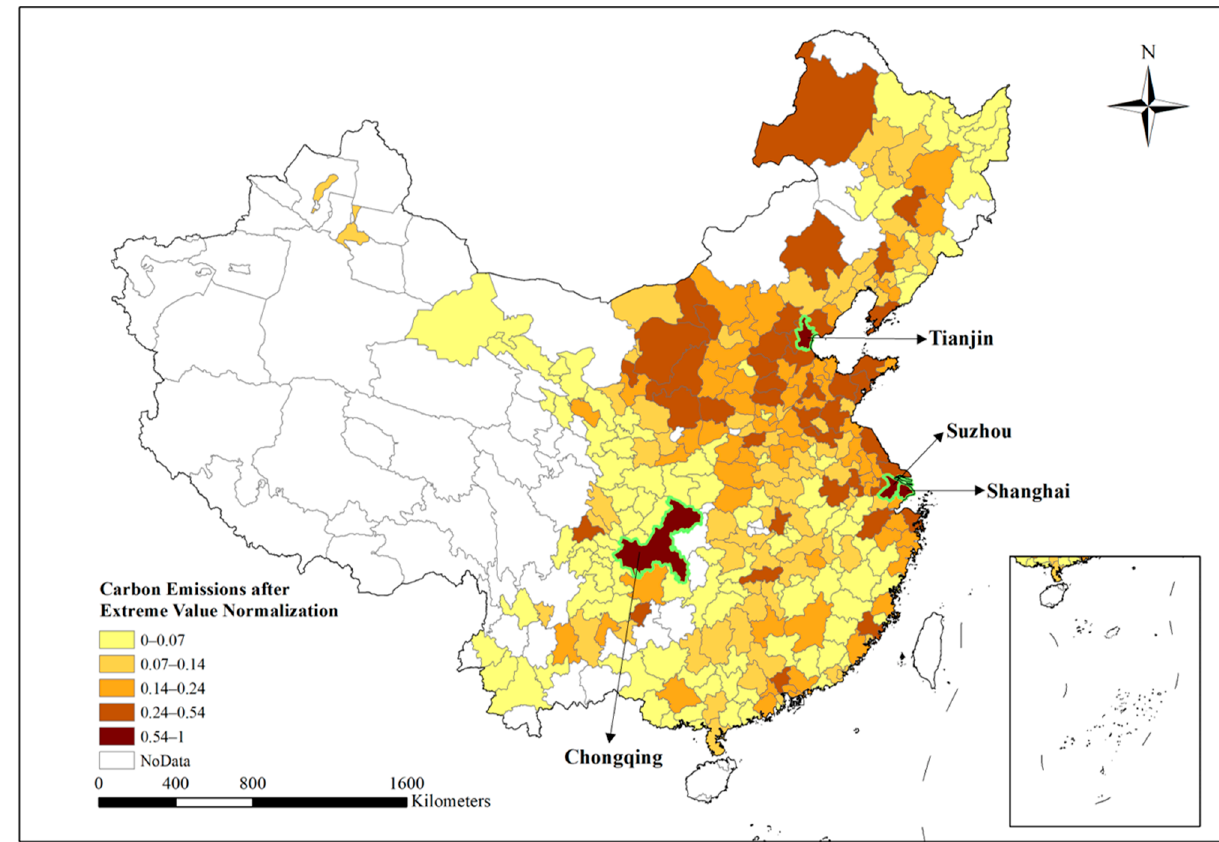
Figure 2. Distribution of carbon emissions in 282 cities.